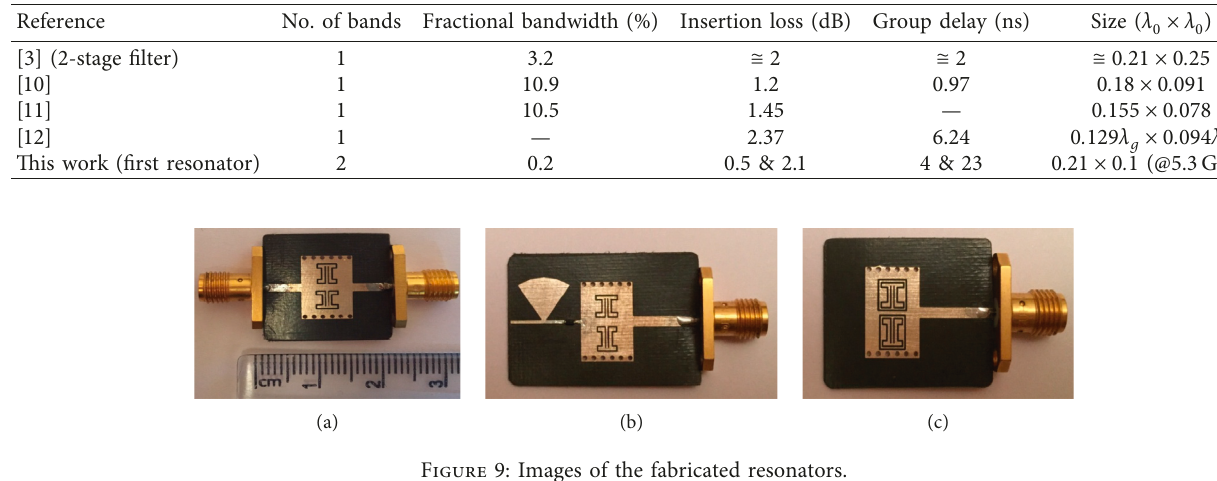
Table 1: Performance comparisons of the recent bandpass filter with the other.